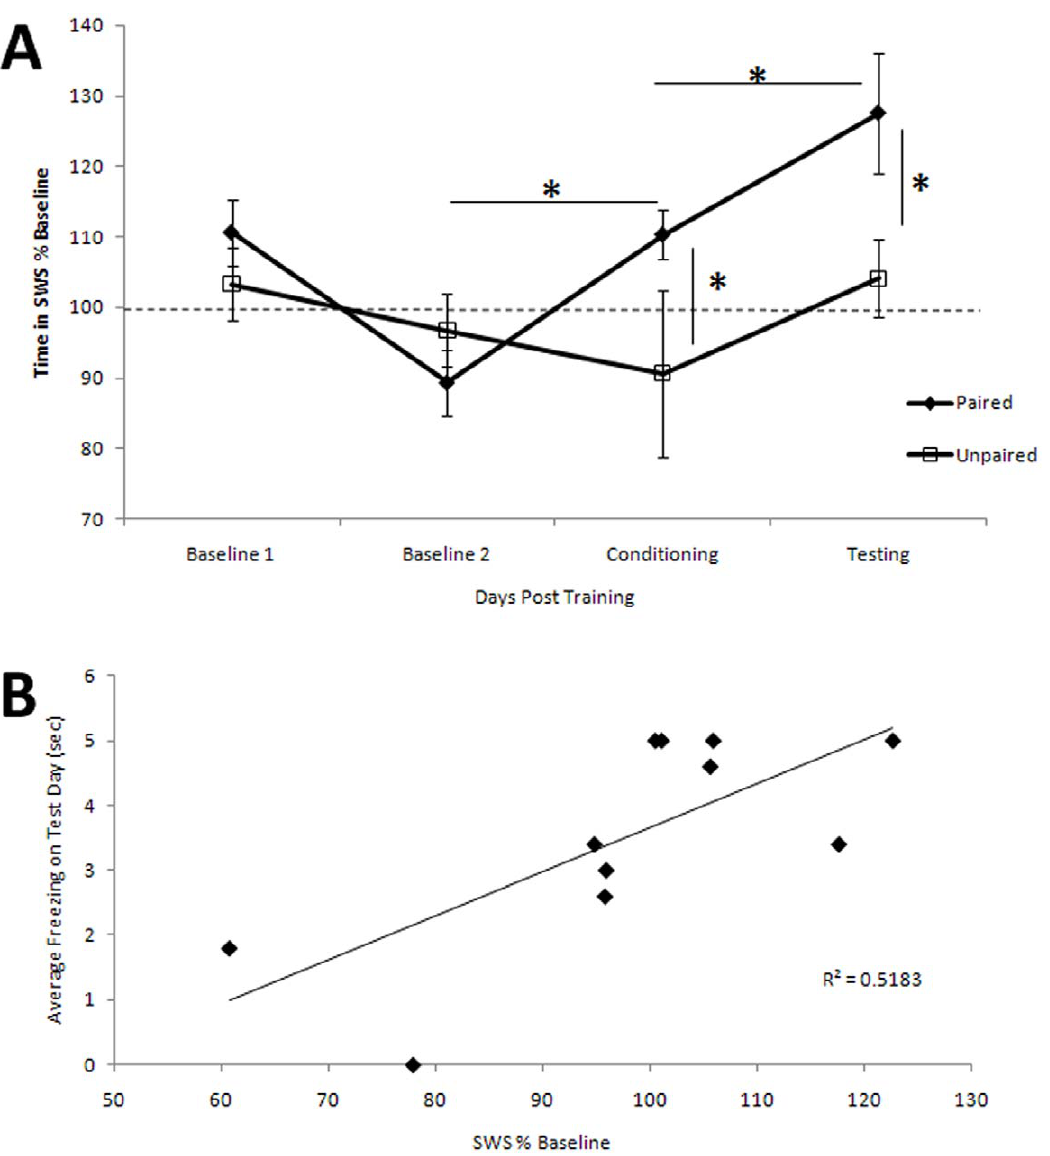
Figure 4. Paired rats increased time spent in post-conditioning SWS. ( A ) Following odor aversion conditioning, paired animals spent more time in SWS recorded in the piriform cortex than on baseline days (mean SWS duration 6 SEM). This increase was seen only in odor/shock Paired animals. Immediately following conditioning (marked by Day Conditioning), Paired animals spent significantly more time in SWS than on baseline days and more time than Unpaired animals. This increase was maintained on the day of testing. There was no significant change in REM or total sleep after conditioning in either group (not shown). Asterisks signify significant difference between groups. ( B) There was a significant correlation between the amount of time spent in SWS immediately after training and the duration of odor-evoked freezing (strength of memory) observed the next day.